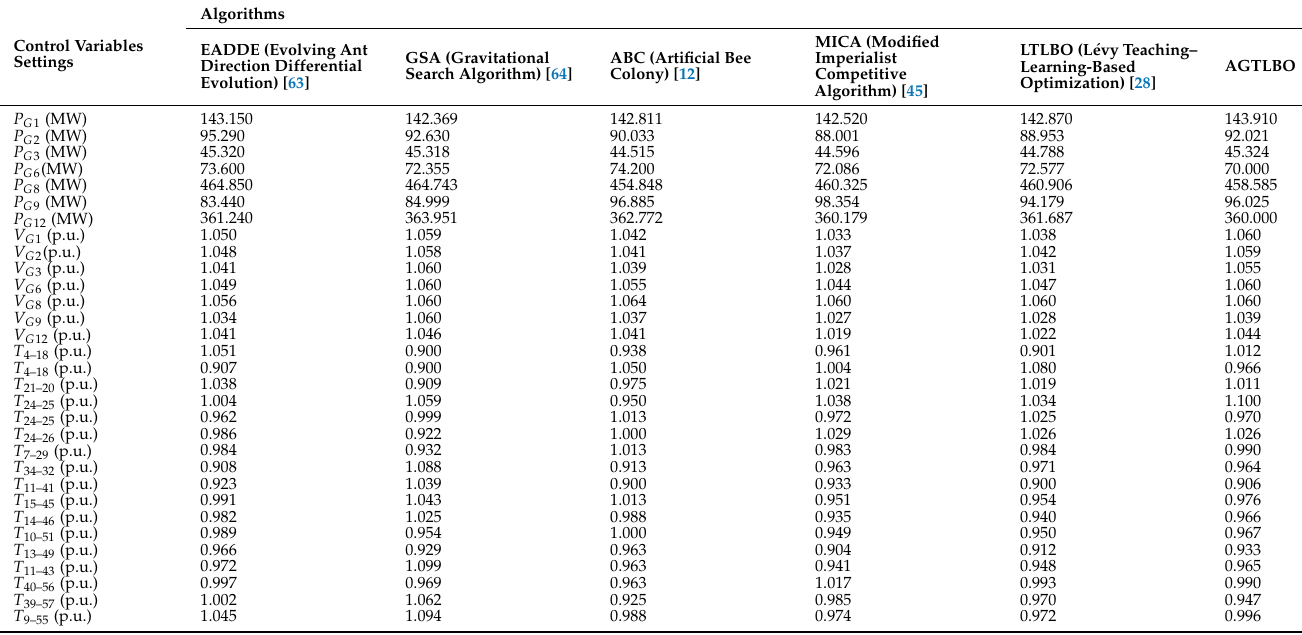
Table 10. Optimal control variables of IEEE 57-bus test system for Case